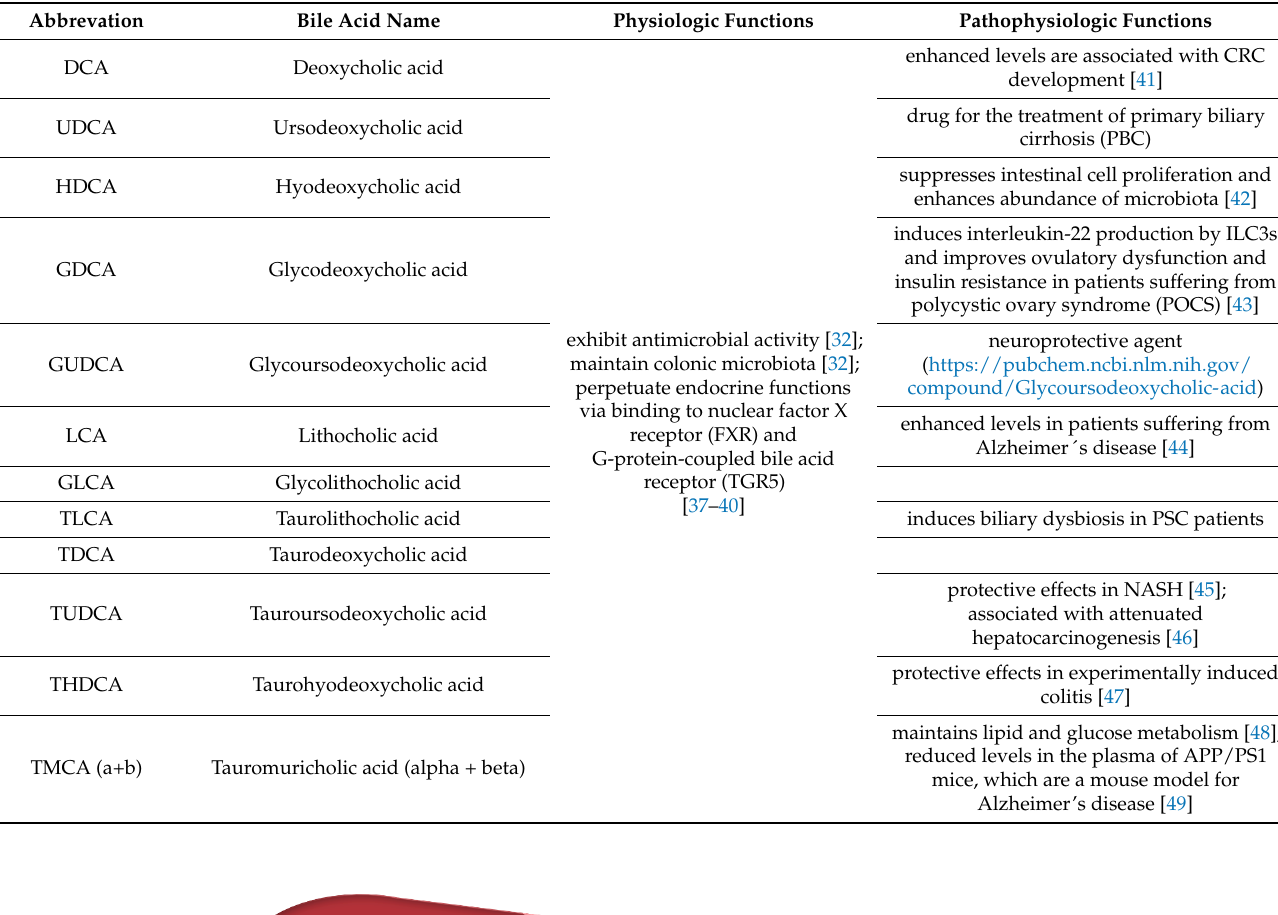
Table 2. Secondary bile acids and their (patho-)physiologic functions (CRC = colorectal cancer, PBS = primary biliary